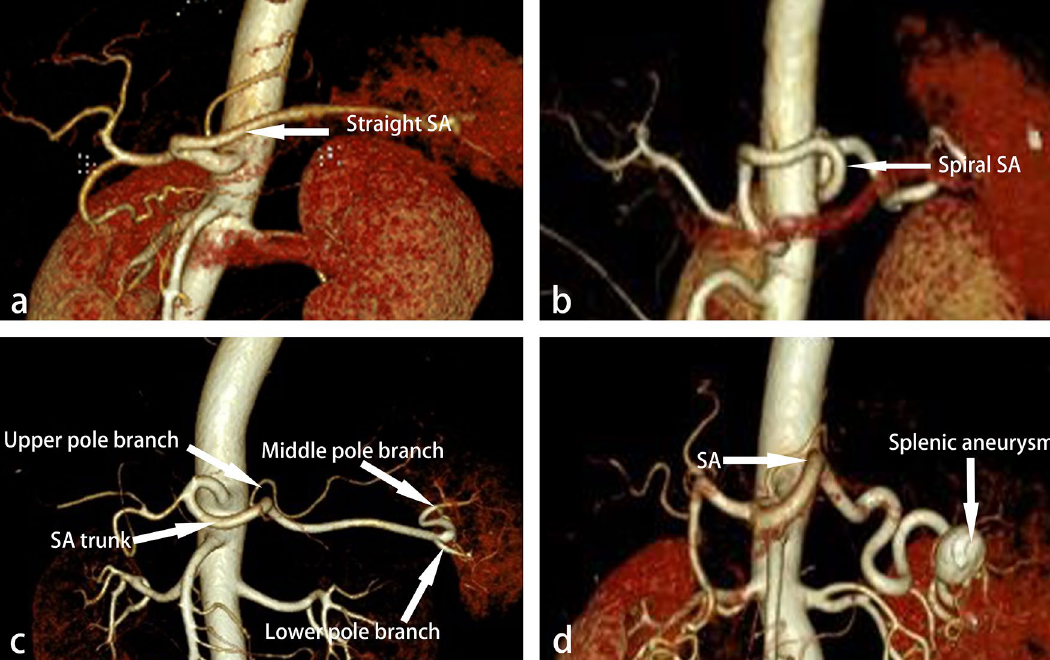
Figure 4. Several anatomical risks of SA. ( a ) A straight SA. ( b ) A spiral SA, as a risk factor for surgery, could significantly increase the rate of vascular injuries. ( c ) The splenic artery is of three-branched type. The middle and lower branches originate, but the upper pole branches originate from the middle parts of the splenic artery. ( d ) In this case, a huge splenic aneurysm was found in the superior branch of the splenic